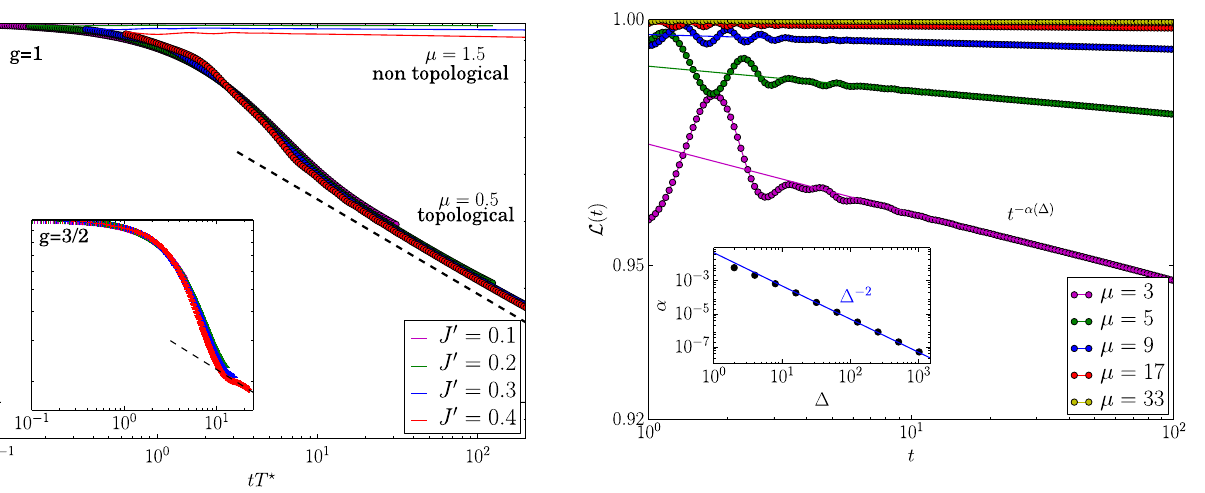
physics.FIG. 2. Loschmidt echo for a quench of the tunneling between a noninteracting normal lead and the Kitaev model for a spinless 1D p -wave superconductor. We work with J ¼ 1 L ¼ 4000 . When the superconductor is topologically nontrivial, the Majorana zero modes at its edges induce a universal decay t − 1 = 4 of the Loschmidt echo (dashed line). The data for different values of the tunneling J 0 collapse once properly rescaled by T ⋆ ¼ ð J 0 =J Þ ½ 2 g= ð 2 g − 1 Þ(cid:3) . Inset: Loschmidt echo for an interac- ting normal lead with Luttinger parameter g ¼ 3 Δ 2 . 5 , and L ¼ 200 (total system size N ¼ 2 L ¼ 400 sites) s ¼ from